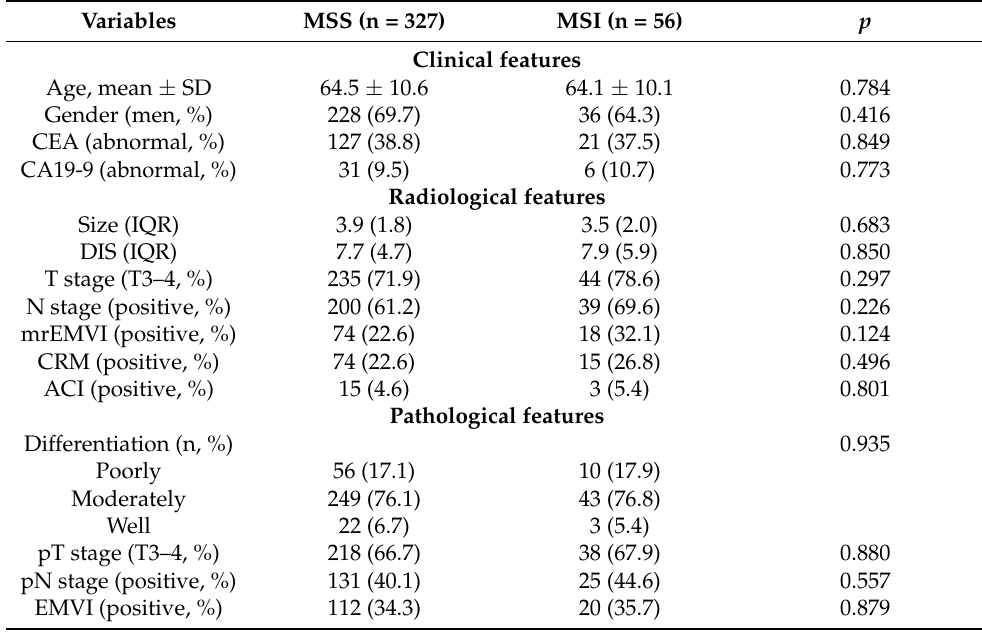
Table 1. Variables between MSS and MSI in the whole